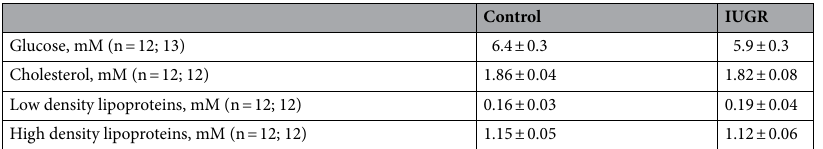
Control IUGR Glucose, mM (n = 12; 13) 6.4 ± 0.3 5.9 ± 0.3 Cholesterol, mM (n = 12; 12) 1.86 ± 0.04 1.82 ± 0.08